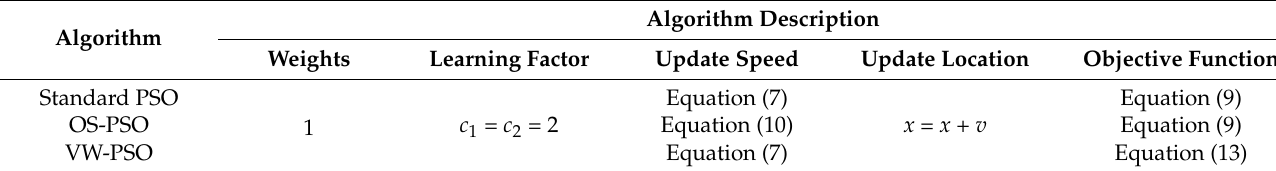
Table 1. PSO variations